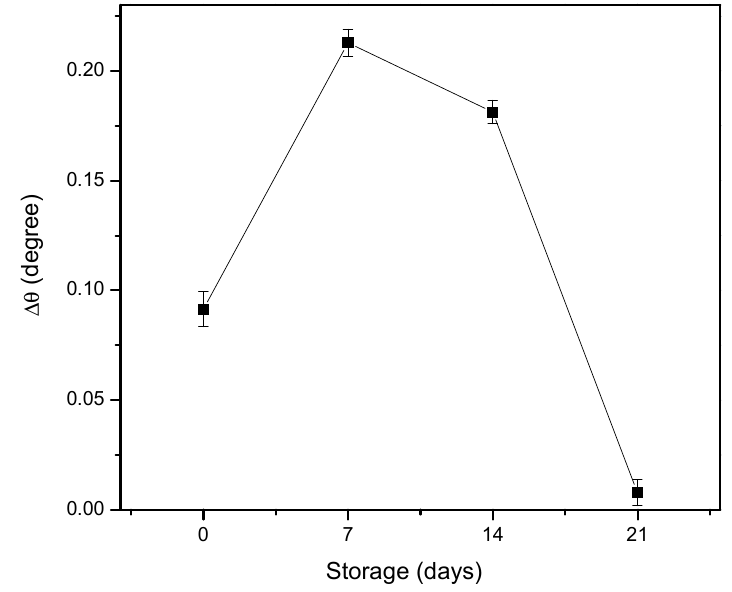
Figure 6. The stability test of Au/DSU/NH 2 rGO–PAMAM/IgM sensor film.